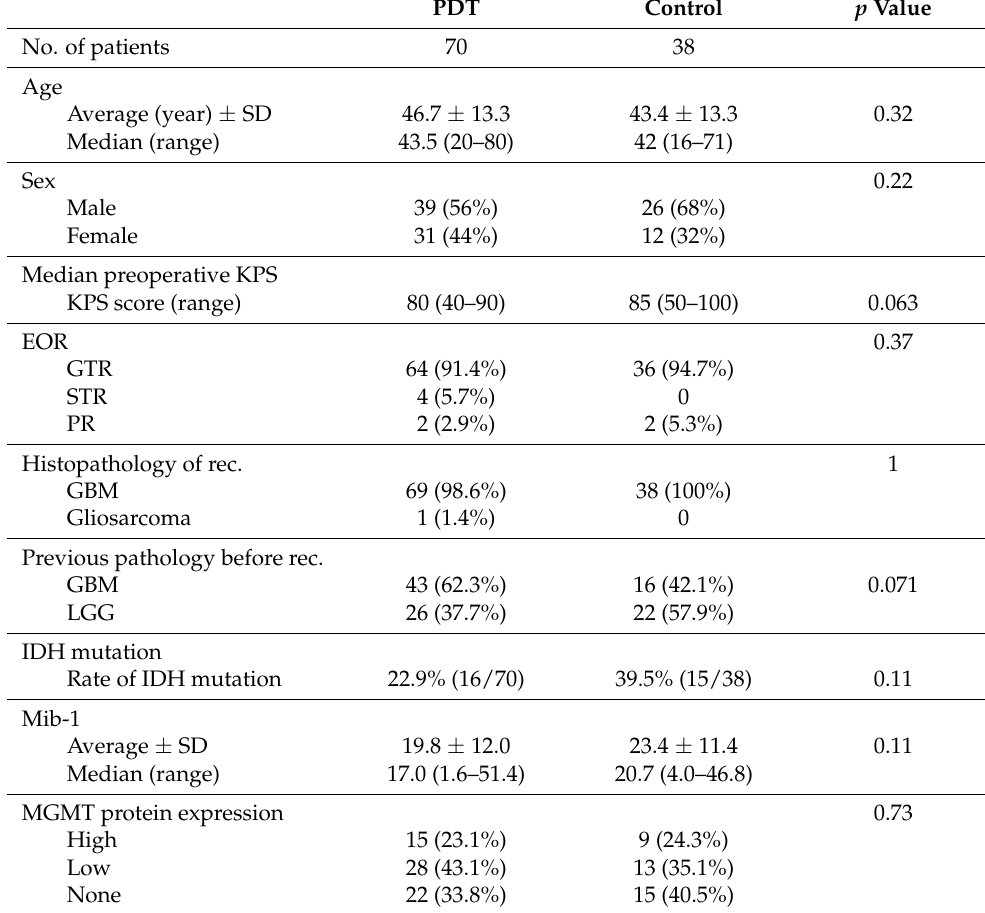
Table 1. Patient demographics and